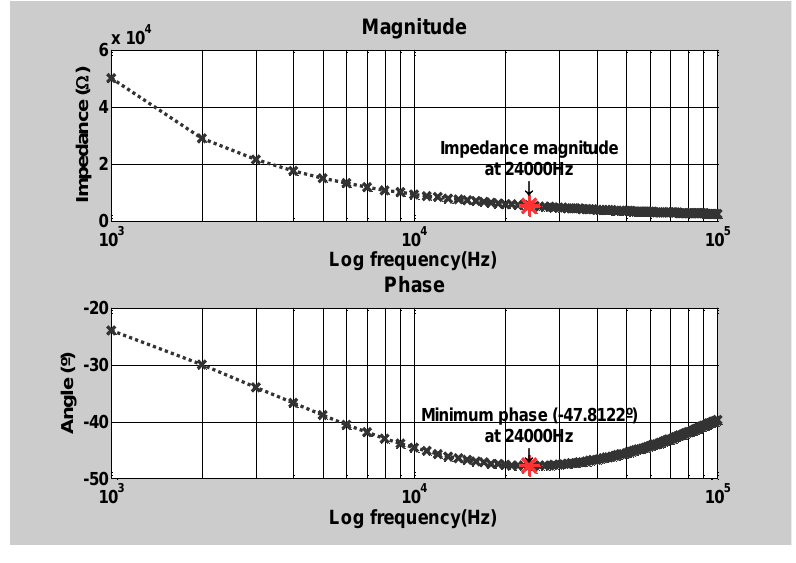
Figure 2. An example of an electrical impedance spectrum obtained. This measurement was taken on day 1 from a lettuce in T50-treatment.